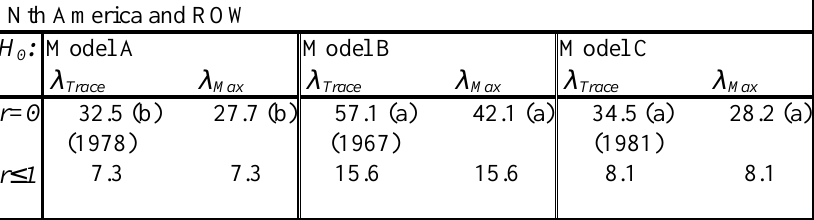
Table 2: Inoue Rank Tests Nth America and ROW H : Model 0